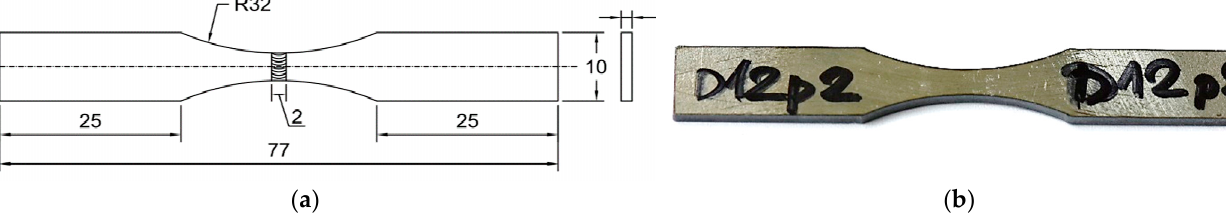
Figure 7. The hourglass specimen with the weld: ( a ) geometry, dimensions, and the weld location (unit: mm), ( b ) manufactured specimen, the nominal thickness was equal to 1.8 mm.